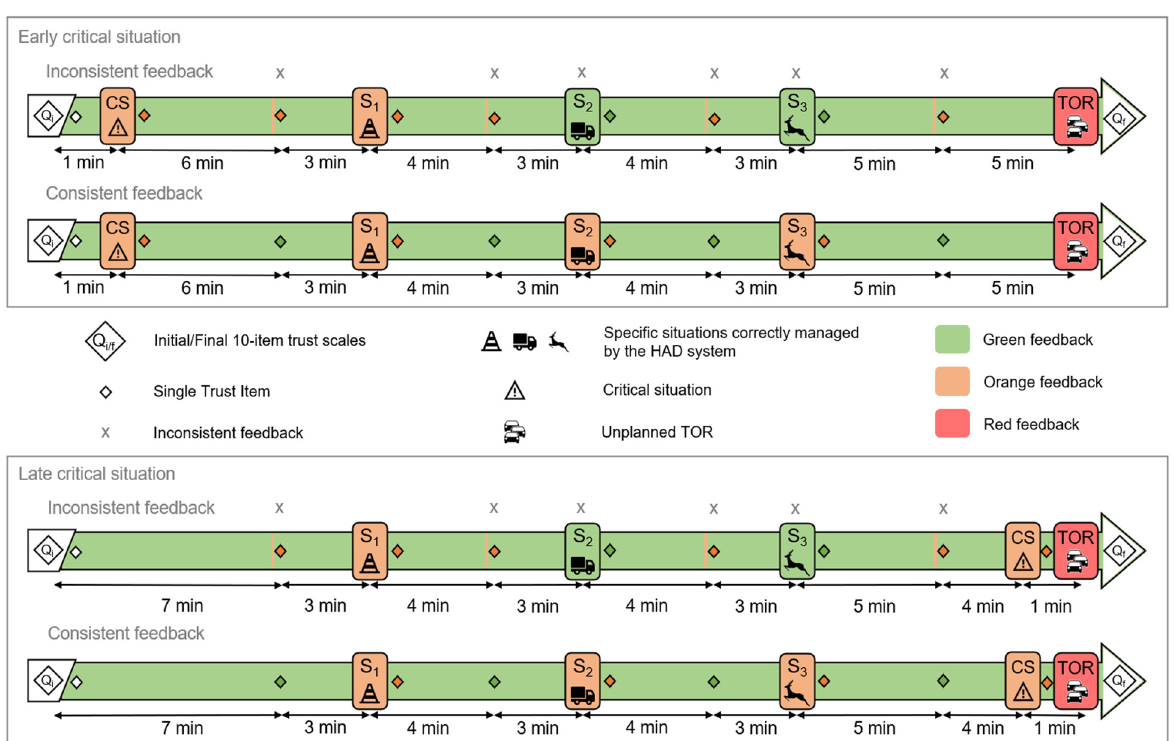
Figure 3. Procedure depending on the assigned conditions.